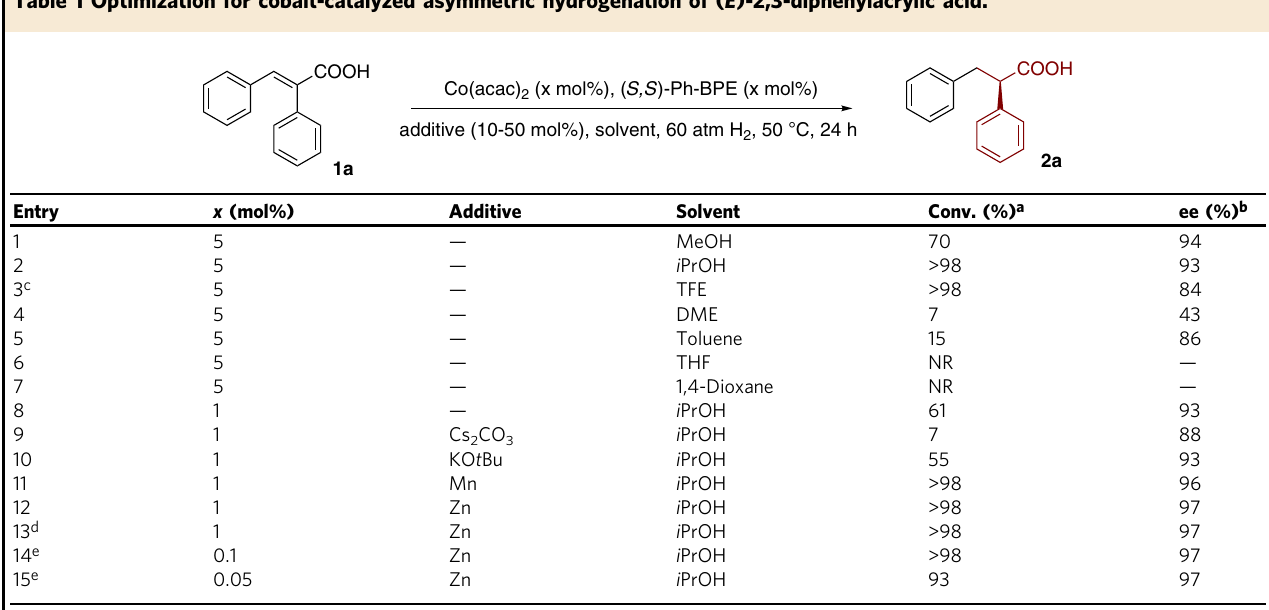
Fig. 3 The performance of chiral diphosphine ligands in Co-catalyzed asymmetric hydrogenation of 1a. The yields were determined by 1 H NMR and the enantioselectivities were determined by HPLC analysis in all cases. Table 1 Optimization for cobalt-catalyzed asymmetric hydrogenation of ( E )-2,3-diphenylacrylic